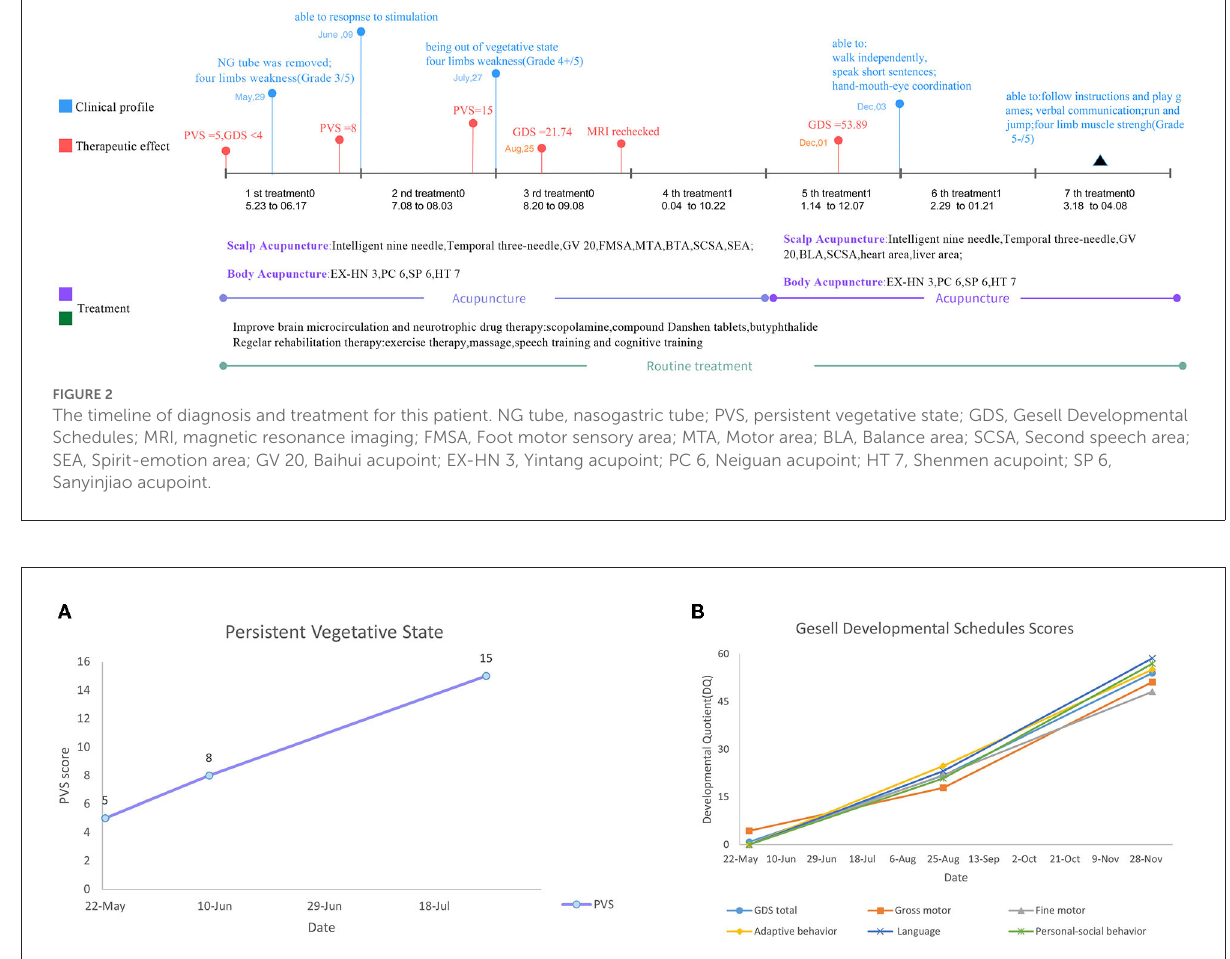
FIGURE3 The therapeutic effect on PVS (A) and GDS score (B) of patient.